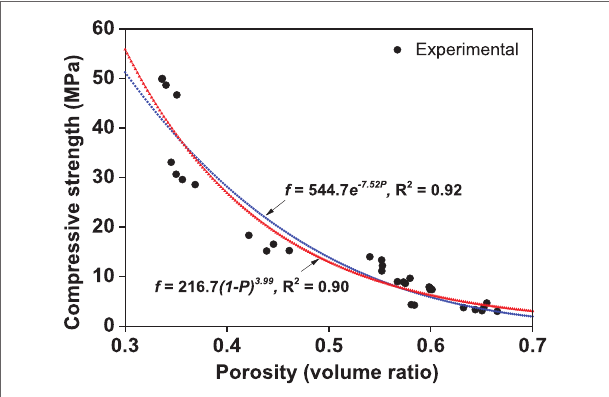
FigUre 8 | The fitting correlations of compressive strength f and porosity P for balshin exponential model ( R 2 = 0.90) and ryshkevitch exponential model ( R 2 = 0.92) .